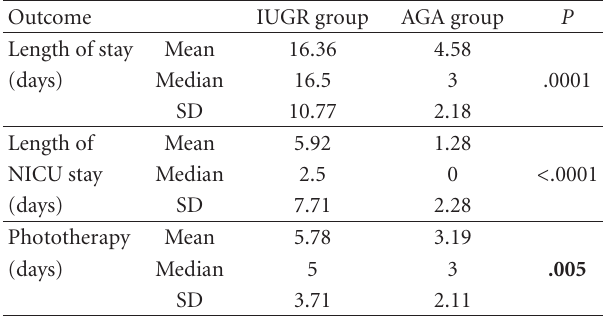
Table 2: Comparison of neonatal outcomes between the IUGR and AGA groups.